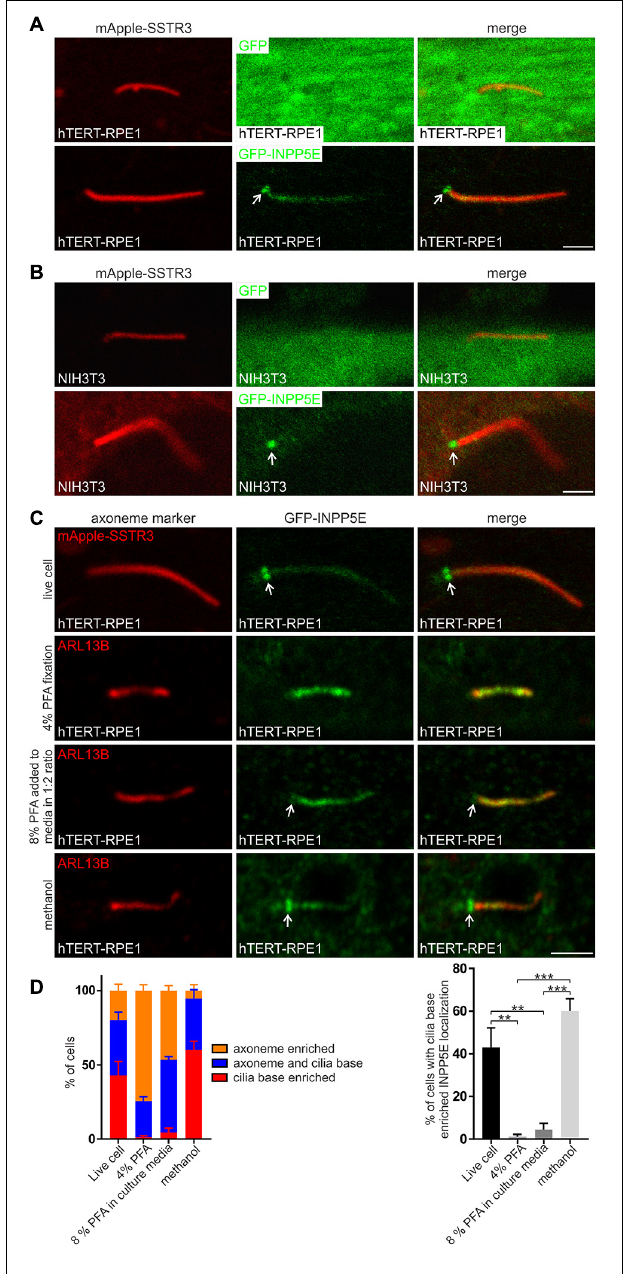
FIGURE 7 | INPP5E localizes to the transition zone. (A) hTERT-RPE1 or (B) NIH3T3 cells were transfected with mApple-SSTR3 and GFP or GFP-INPP5E, serum starved and imaged live by confocal microscopy. Arrow indicates transition zone INPP5E localization, bar indicates 2 µ m. (C) hTERT-RPE1 cells were transfected with GFP-INPP5E ± mApple-SSTR3, serum starved and imaged live or immunostained with GFP (green) and ARL13B (red) antibodies using 4% PFA, 8% PFA added directly to the culture media in a 1:2 ratio or –20 ◦ C methanol fixation and imaged by confocal microscopy. Arrow indicates transition zone INPP5E localization, bar indicates 2 µ m. (D) Graphs show the percentage of cells exhibiting exclusive axoneme, exclusive transition zone or axoneme and transition zone INPP5E localization. Bars represent mean ± SEM, n = 3 independent experiments, 30 cilia imaged per experiment, statistical significance was determined by one-way ANOVA ( p = 0.0002) followed by Tukey’s post hoc test ** p < 0.01, *** p < 0.001.